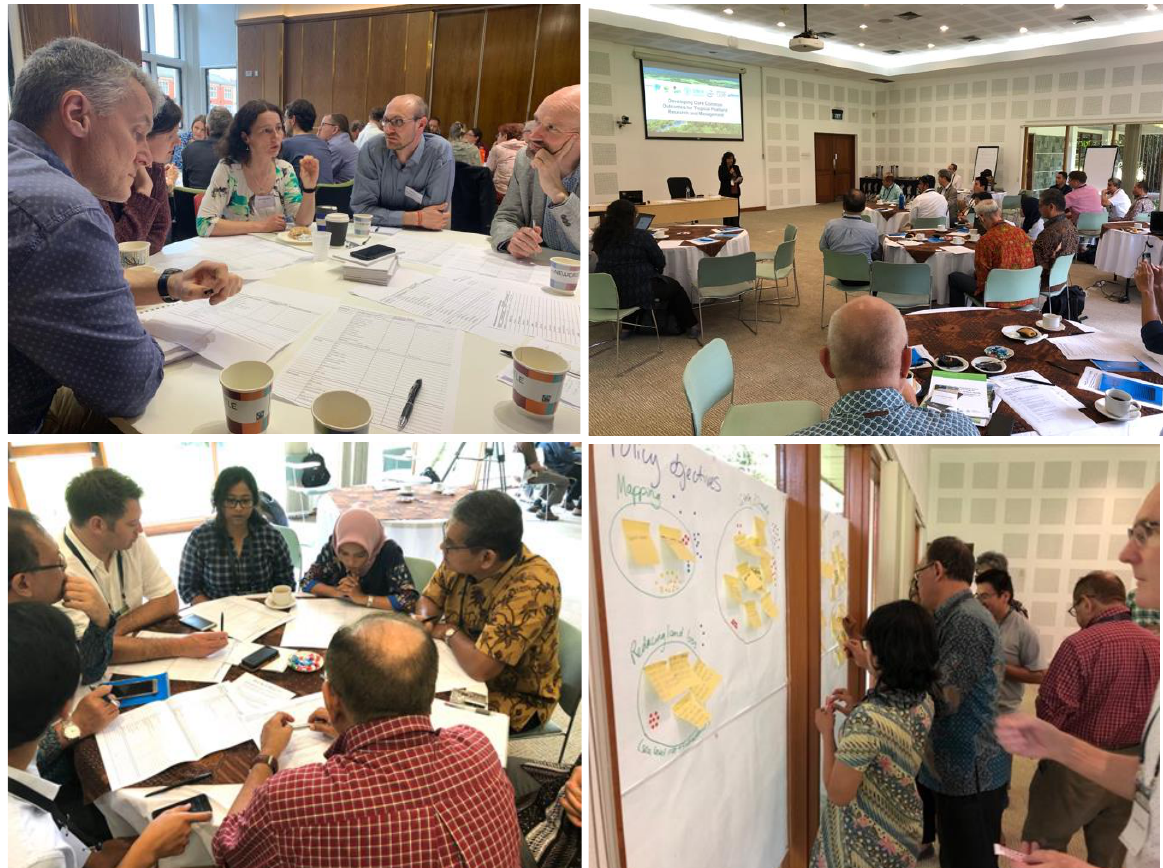
Figure 3. Clockwise from top left: Participants discussing UK peatland domains in Newcastle, UK (March 2019); Dr Haruni Krisnawati from the International Tropical Peatland Centre opening the workshop to prioritise tropical peatland outcomes in Bogor, Indonesia (July 2019); participants prioritising policy objectives (Bogor); and deliberation over core outcomes